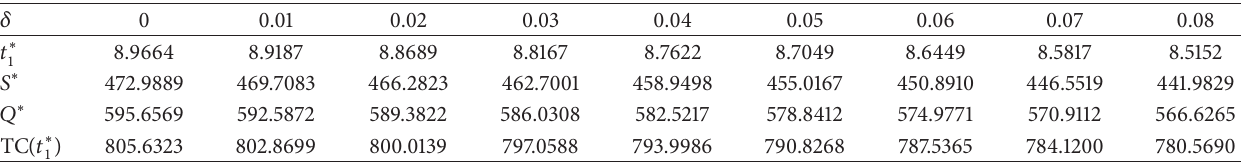
Table 1: The sensitivity of 𝛿 for the models in Example 1.